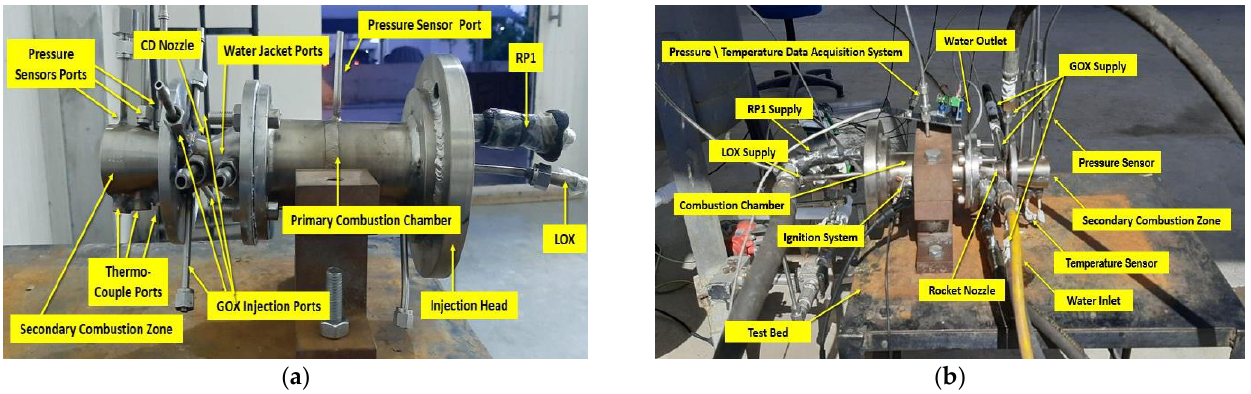
Figure 14. ( a ) Gas generator major components. ( b ) Gas generator with configured instrumentation.